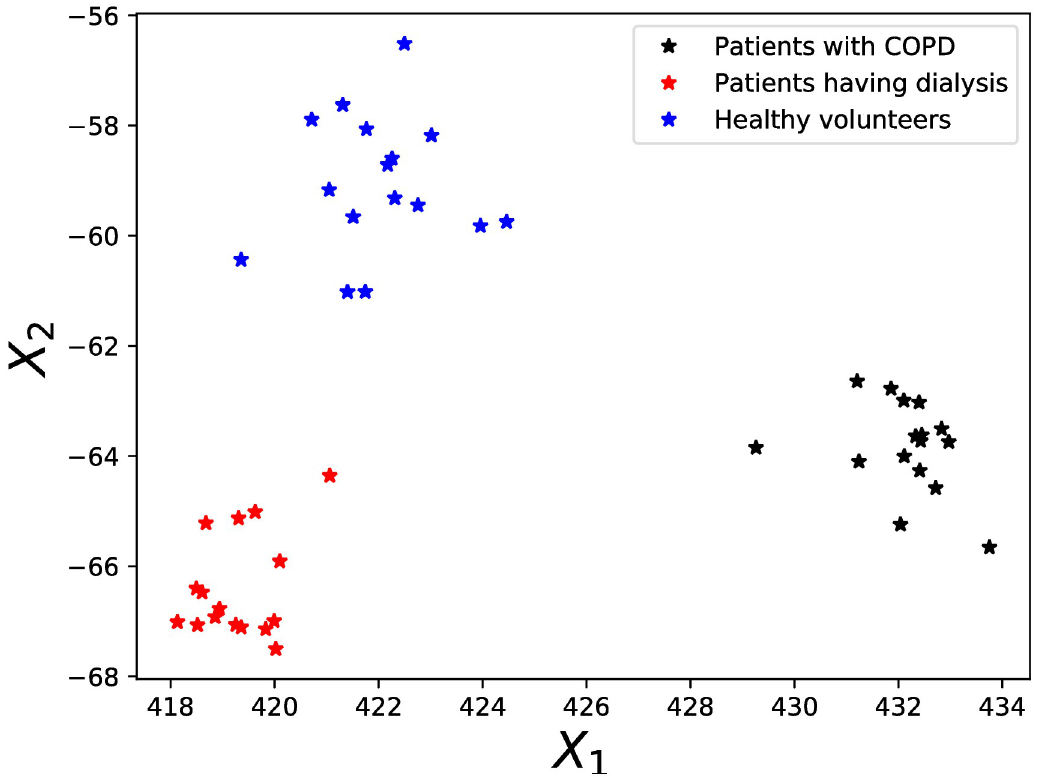
Fig 6. Discriminative summary statistics space. The discriminative summary statistics space learned by DSSL, in which the patients with COPD, patients having dialysis and healthy volunteers were accurately clustered.